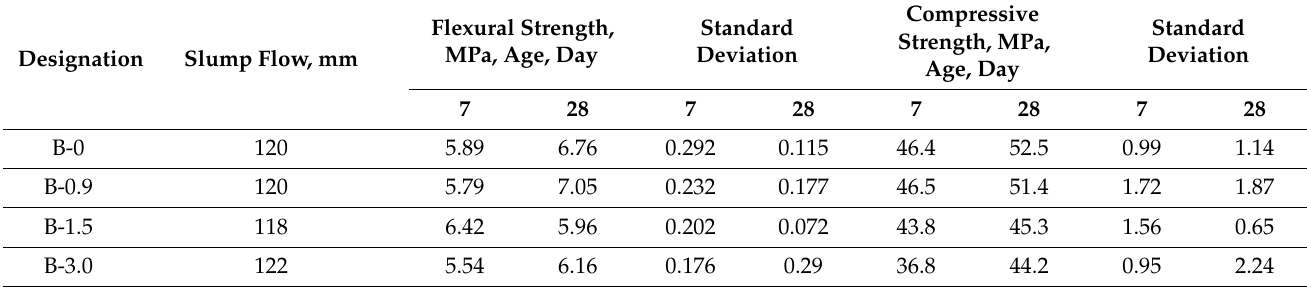
Table 2. Results of bending and compression testing of series B prism specimens 40 × 40 × 160